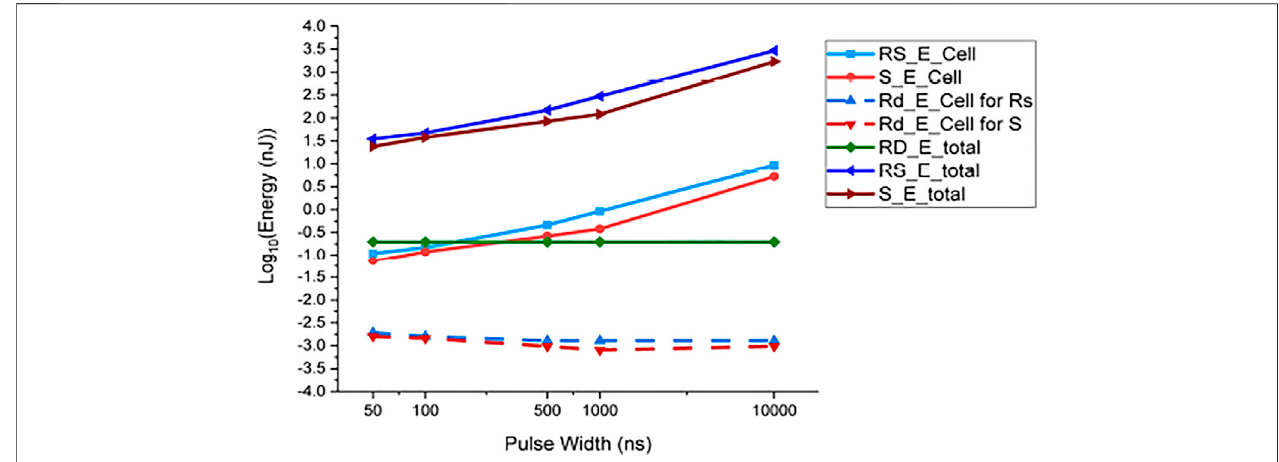
FIGURE 11 | Average energy required to do reset (blue dots) and set (red dots) operations, read energy for set and reset, and total read on a single 1T1R ReRAM cell and 4 Kbit ReRAm memory arrays.